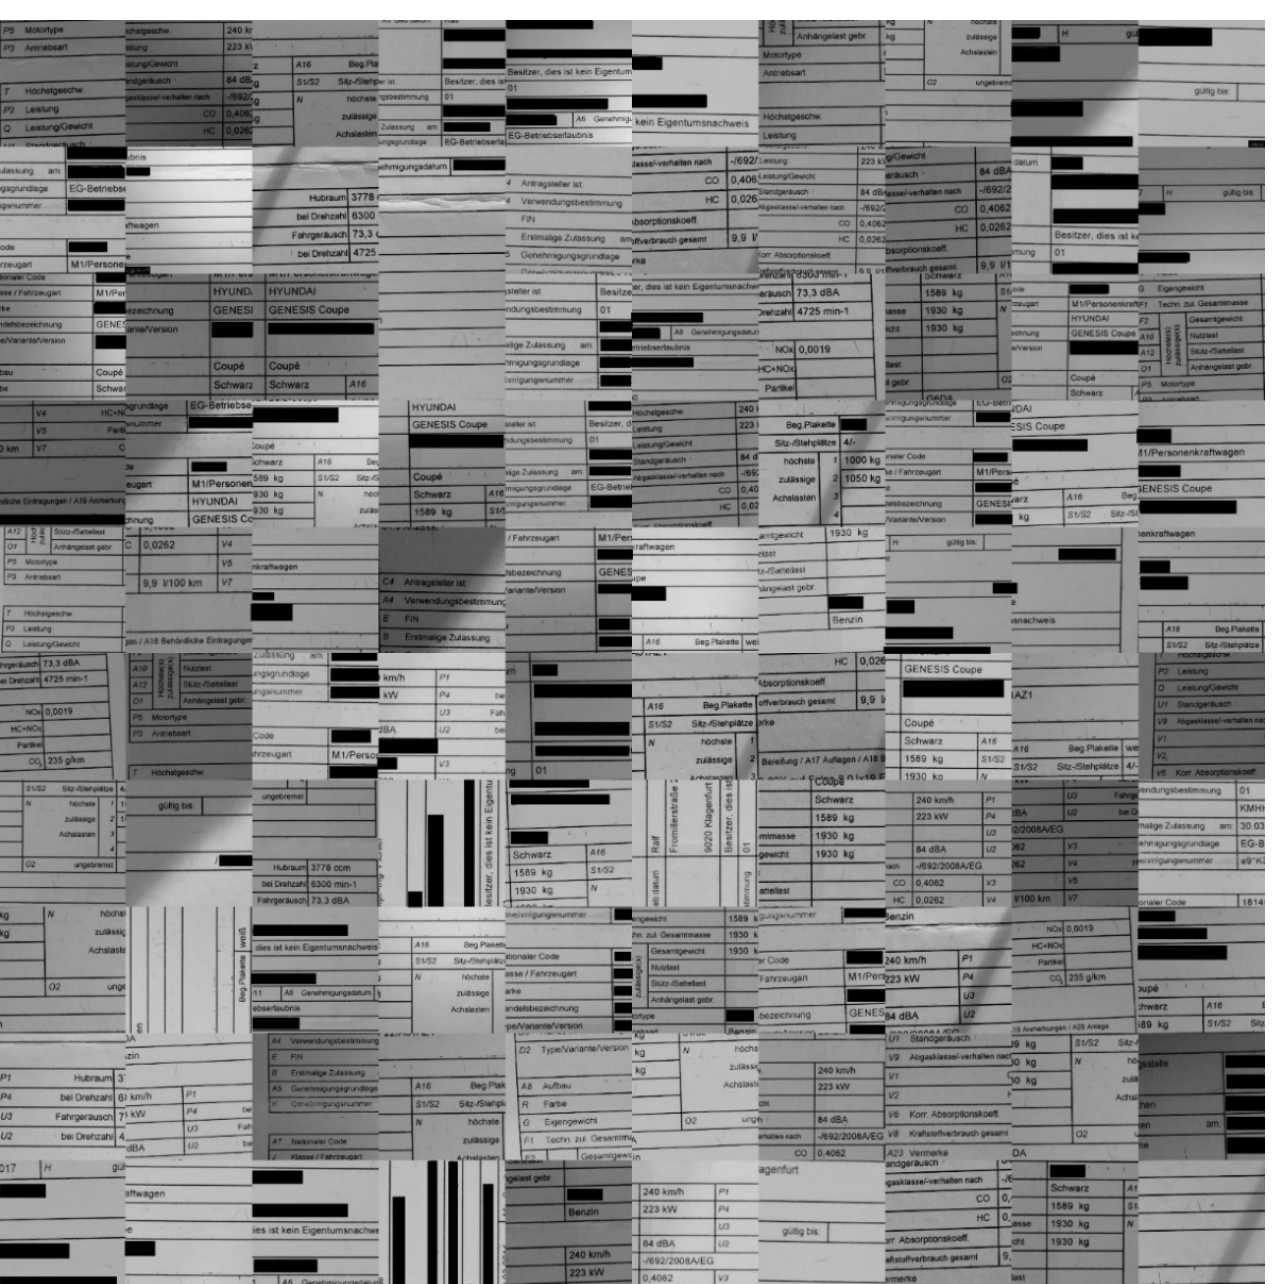
Figure 10. These are 100 “very good quality ” sample data extracted from our own dataset (an extract from a much bigger dataset). Note: since the images contain some personal data, those parts are covered by black rectangles for privacy